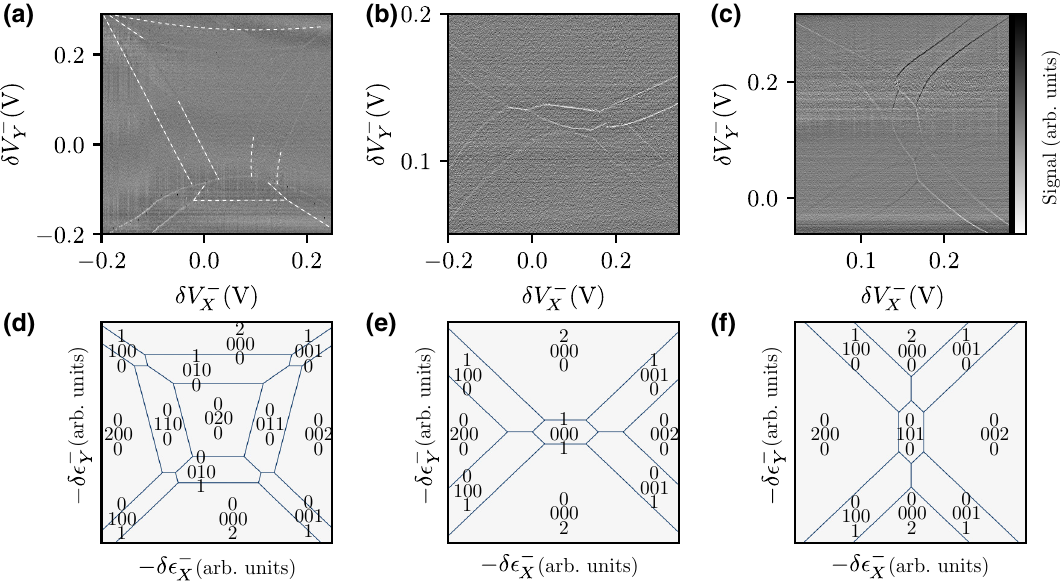
FIG. 2. Two-electron stability diagrams. (a)–(c) Charge-stability diagrams of two electrons in the five dots L , B , R , T , and C (a) or in the four dots L , B , R , and T (b),(c). The charge state of the array of dots is controlled by sweeping δ V − combinations of the quantum point contact current derivatives: (a),(c) ∂ in (a) are a guide for the eye for weak-intensity degeneracy lines. The stability diagrams are obtained for different gate-voltage tunings. (d)–(f) Simulations of the stability diagrams. The labels indicate the position of the isolated electron in the QD